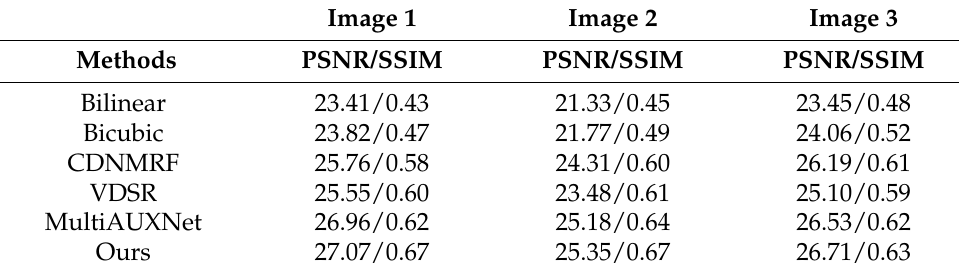
Table 2. The PSNR and SSIM results of different super-resolution networks.